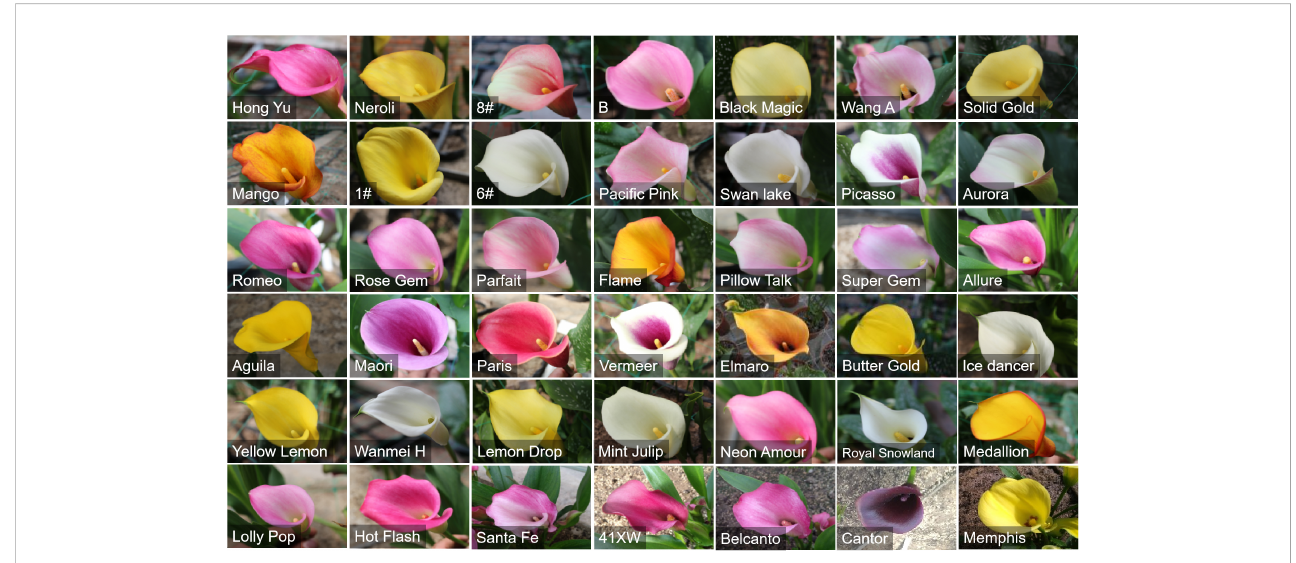
FIGURE 6 Total 42 core germplasms of colored calla lily de fi ned by the software Power